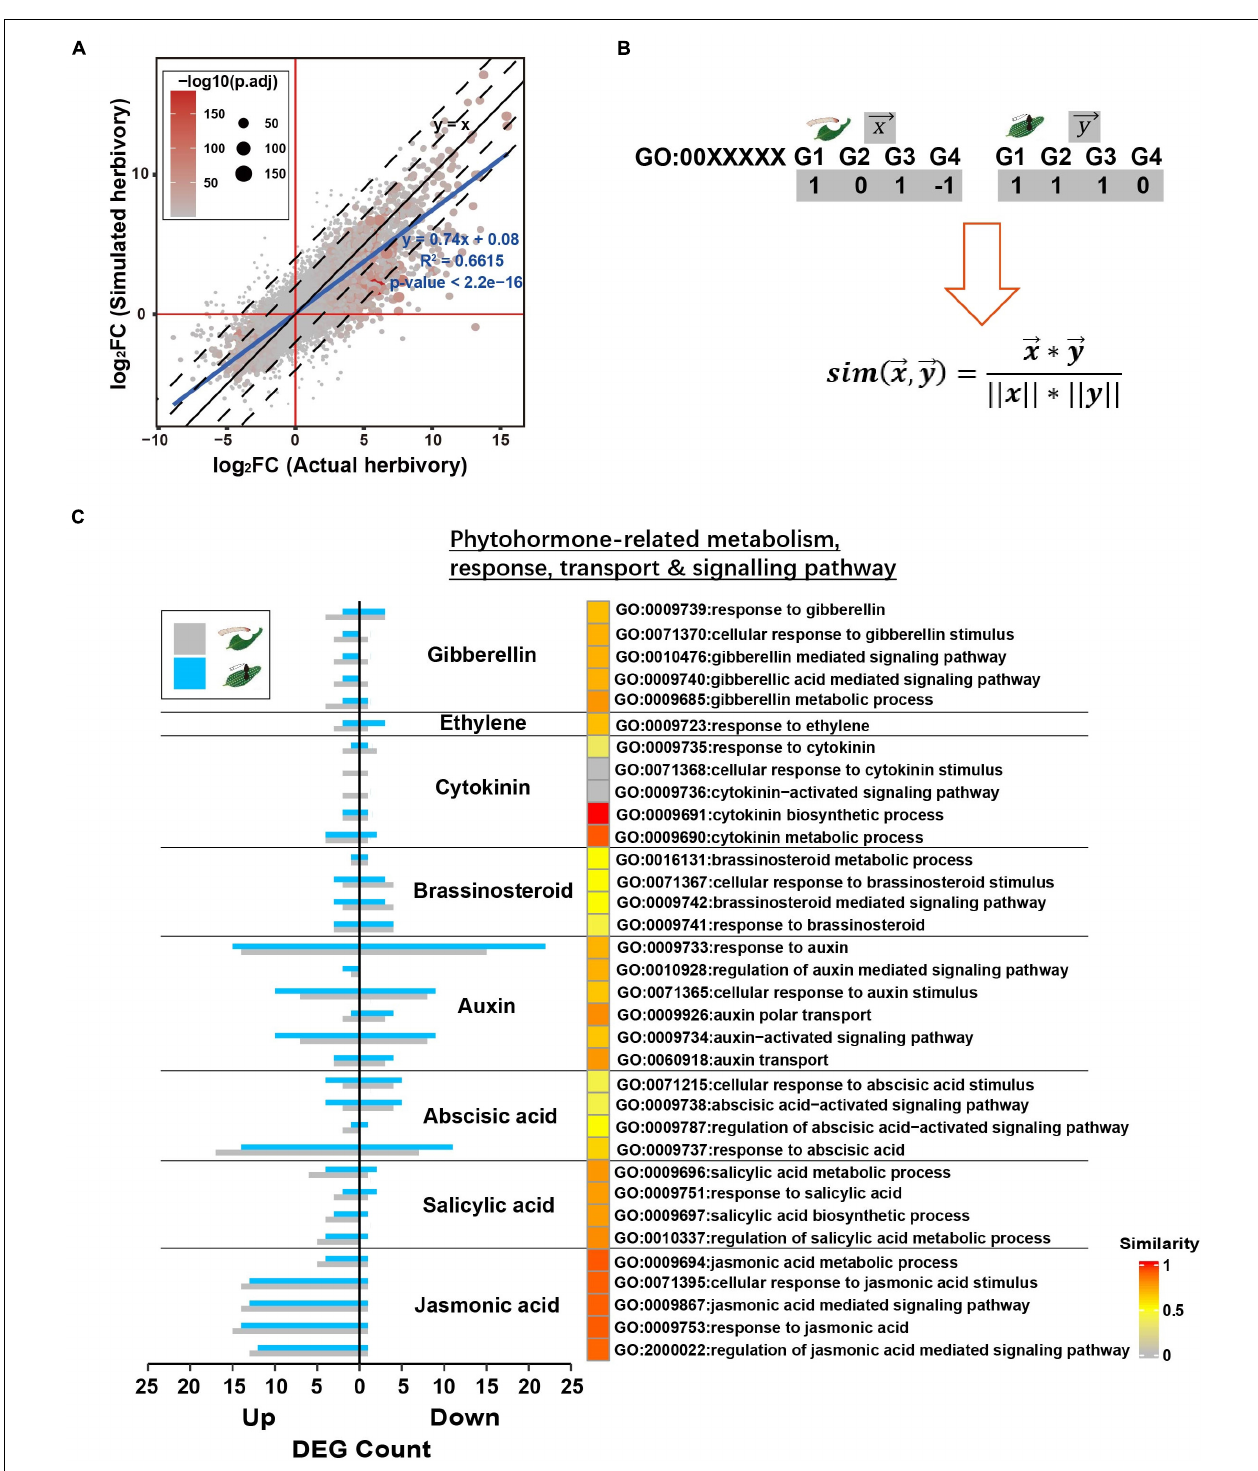
FIGURE 4 | Simulated herbivory and actual herbivory induced similar early transcriptomic response of potato plants. (A) Log2(fold change) of all genes of simulated herbivory group and actual herbivory group was compared in a dot plot. If simulated herbivory and actual herbivory induced the same responses, all genes should fall in y = x . (B) The overview to quantify inductive similarity of two treatments in a GO; treatment X and Y induced DEGs in a GO (1, upregulated DEG; –1, downregulated DEG; 0, non-significant gene); the DEG vector x and y were plugged into equation to calculate similarity. (C) The inductive similarity between actual herbivory and simulated herbivory in all phytohormone-related GOs. The DEG number of simulated herbivory and actual herbivory in each GO is exhibited as bar plot. The similarity was mapped to heatmap color from gray to red.